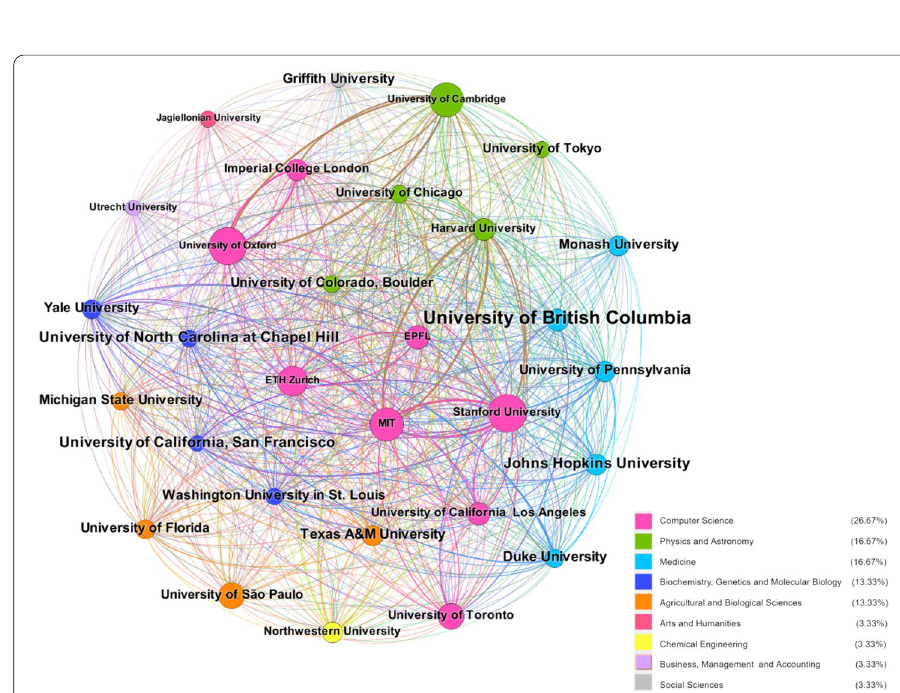
Fig. 9 A subgraph of the AIN. The color of a node indicates the majority of fields of interest. The size of a node corresponds to the number of its authors, and the size of its label corresponds to its